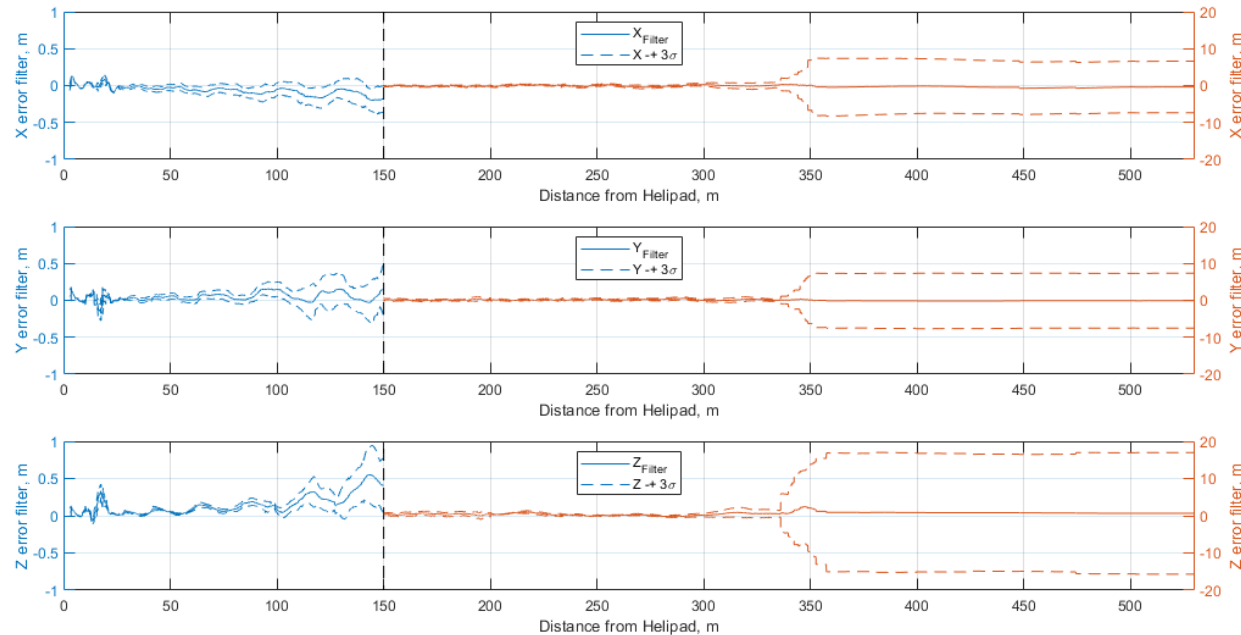
Figure 14. EKF position estimates errors average over 50 simulations and 3 − sigma bounds. 3 − stepped landing trajectory in nominal visibility conditions with disturbances applied to the path. The plot scale is increased in the last 150 m to better show the errors in the final phase of the approach. Table 4. Mean ( μ ) and standard deviation ( σ ) over 50 simulations of the EKF position estimates errors computed along different sections of the disturbed trajectories in nominal visibility conditions. Trajectory